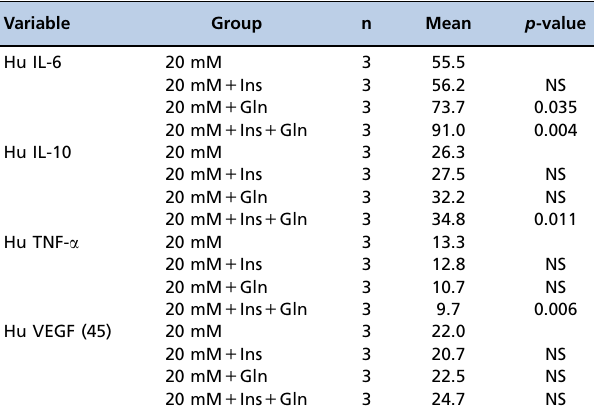
Table 1 - Cytokine analysis comparing 20 mM glucose, 20 mM glucose + Ins, 20 mM glucose + Gln, and 20 mM glucose + Ins +